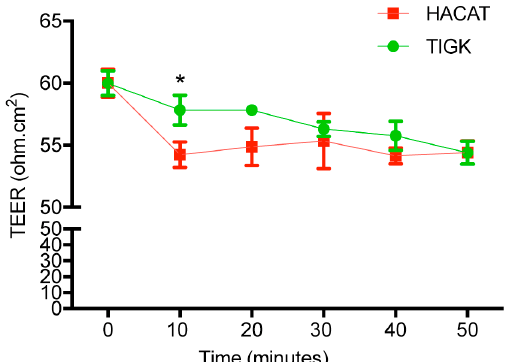
Figure 6. Histamine treatment significantly reduced barrier function in skin keratinocytes. HaCaT and TIGK cells were cultured in 12-well cell culture plates using inserts with pore size of 0.4 µm. At confluency, serum-free DermalLife K Complete medium used in the initial culture with low calcium concentration (0.06 mM) was replaced with high calcium concentration (1.8 mM) DMEM in 10% FBS for 10 days. Cells in the inserts were then treated with histamine (100 µM). The transepithelial electrical resistance (TEER) was measured every 10 minutes. n = 3 replicates, * p < 0.05 .